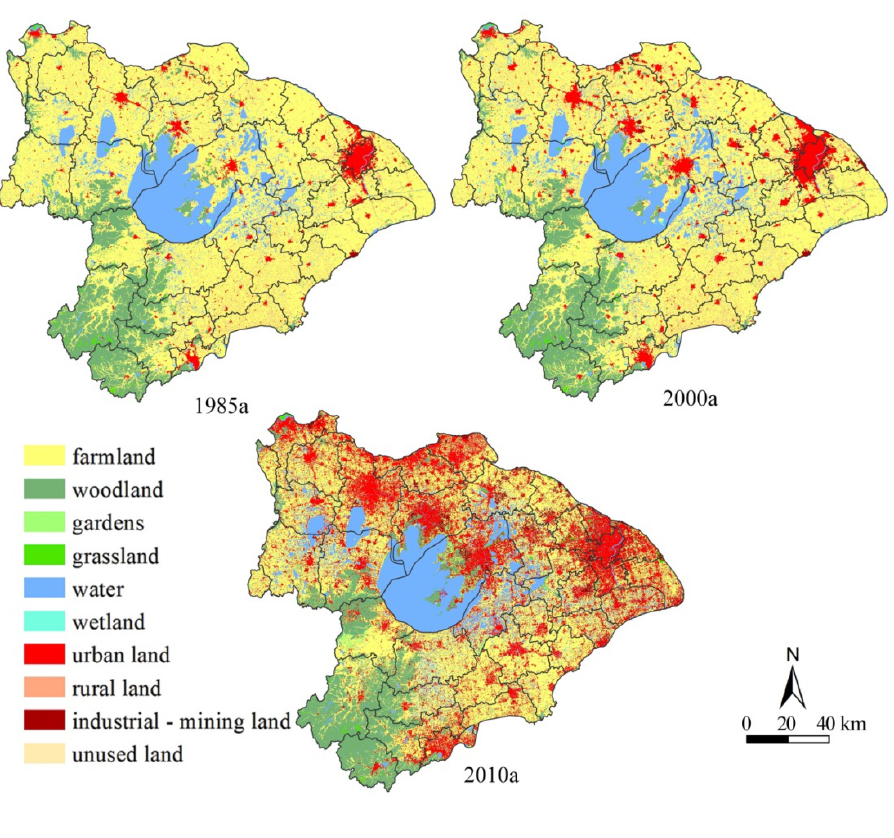
Figure 2. The spatial pattern of AFOS change.